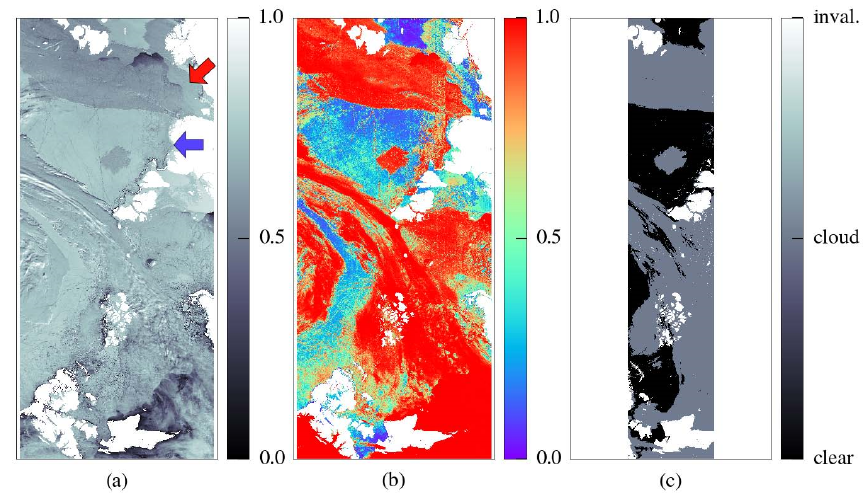
Figure 3. Reflectance at 779nm (a) , cloud probability (b) and corresponding AATSR mask (c) for 14 May 2009 with Svalbard at the bottom left corner. Land, open water and invalid pixels are white. The red arrow points to missed clouds and the blue one marks wrongly screened-out clear-sky pixels (orbit number 37666).